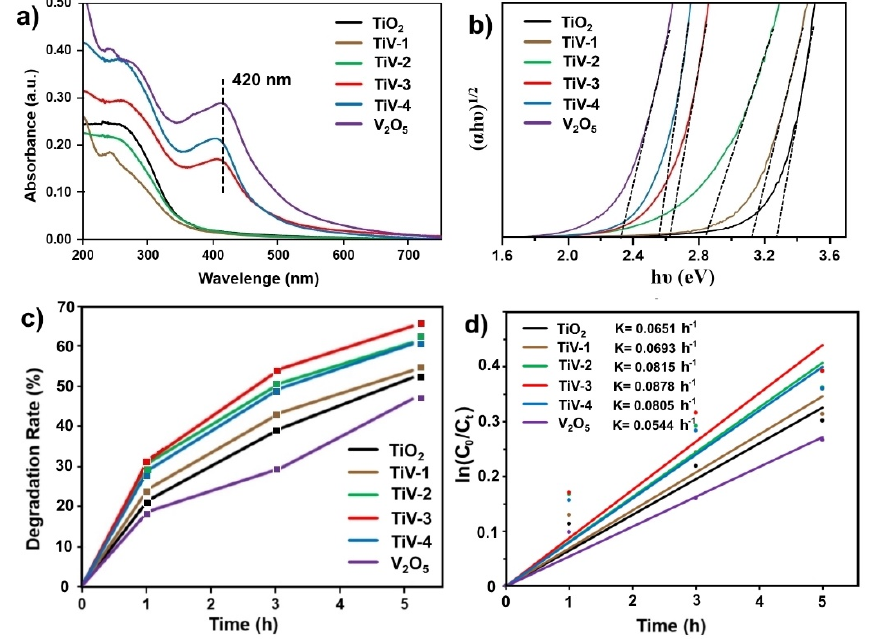
Figure 6. ( a ) UV-Vis absorption spectra, ( b ) Tauc plot, ( c ) Photocatalytic degradation, and ( d ) comparison of the rate constants of MB degradation over samples.